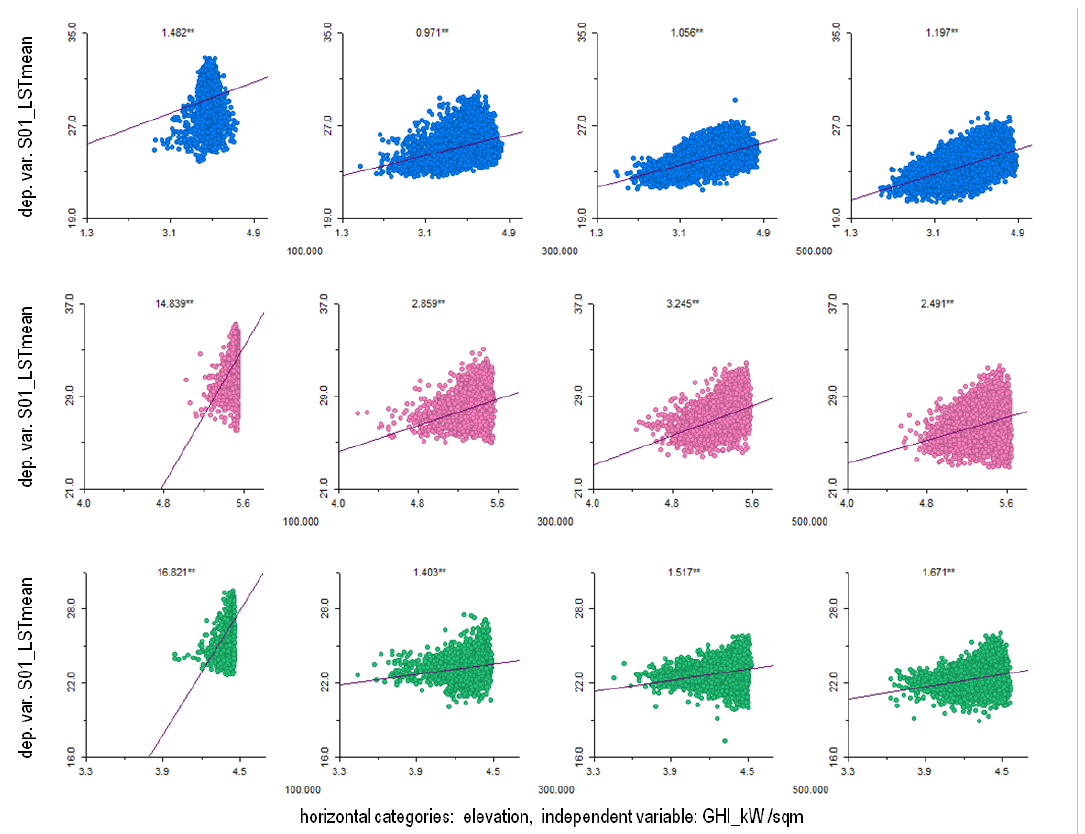
Figure 11. Scatter plots of LST vs. GHI, categorized vertically by season and horizontally by